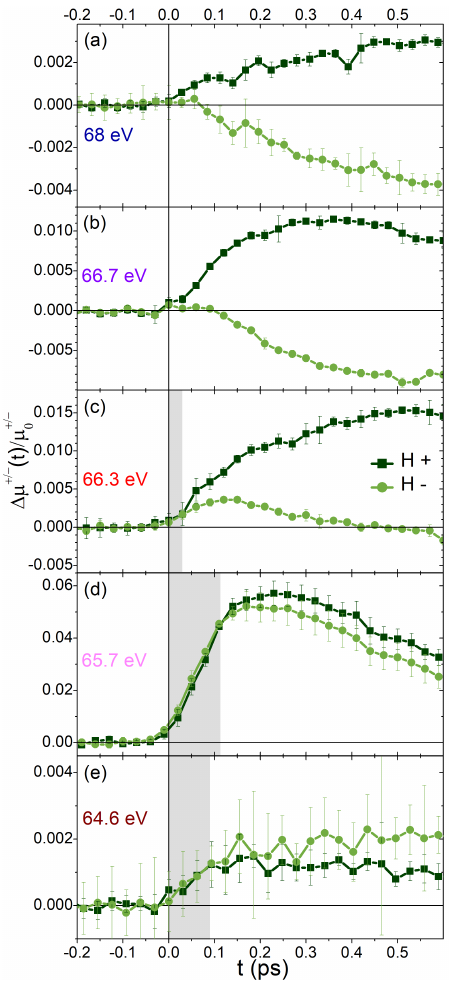
Figure 3. Relative absorption time traces for both field directions: H + shown in dark green and H − shown in light green using XUV probing energies equal to ( a ) 68 eV ( b ) 66.7 eV ( c ) 66.3 eV ( d ) 65.7 eV and ( e ) 64.6